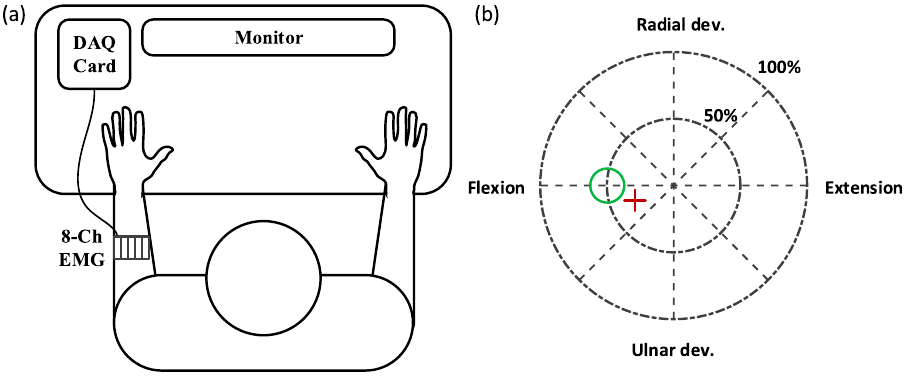
Figure 1. ( a ) Experimental setup, consisting of eight Otto Bock 13E200AC EMG electrodes equally spaced around the forearm and powered by a prosthesis battery pack, a National Instruments Data Acquisition (DAQ) card, and a PC with separate user screen. ( b ) Feedback window in real-time control tasks. The user controls the position of the red cross with his/her EMG signals, utilizing either a classifier or a regressor. The task is to move and keep the red cross into the green circle in the conditions